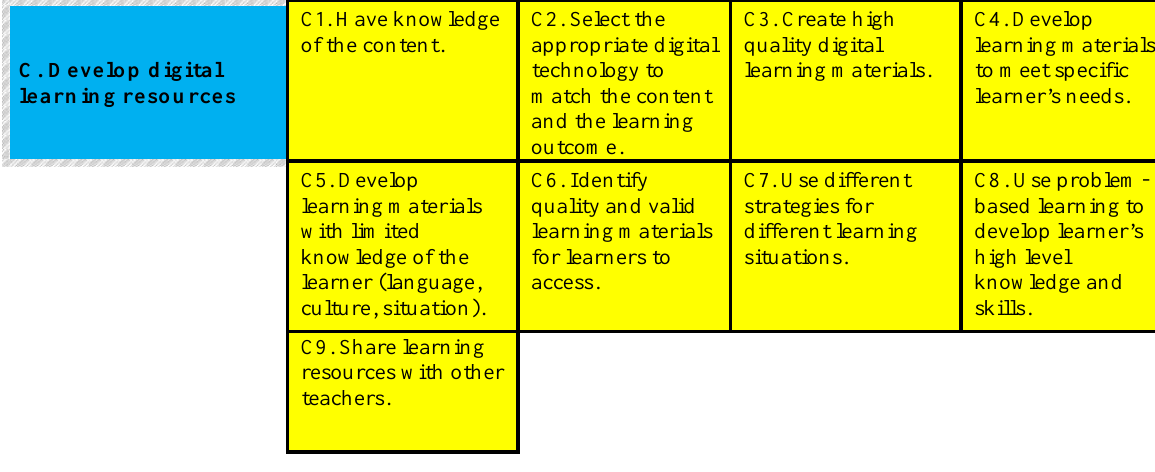
Figure 5. Develop digital learning resources compertencies for the digital